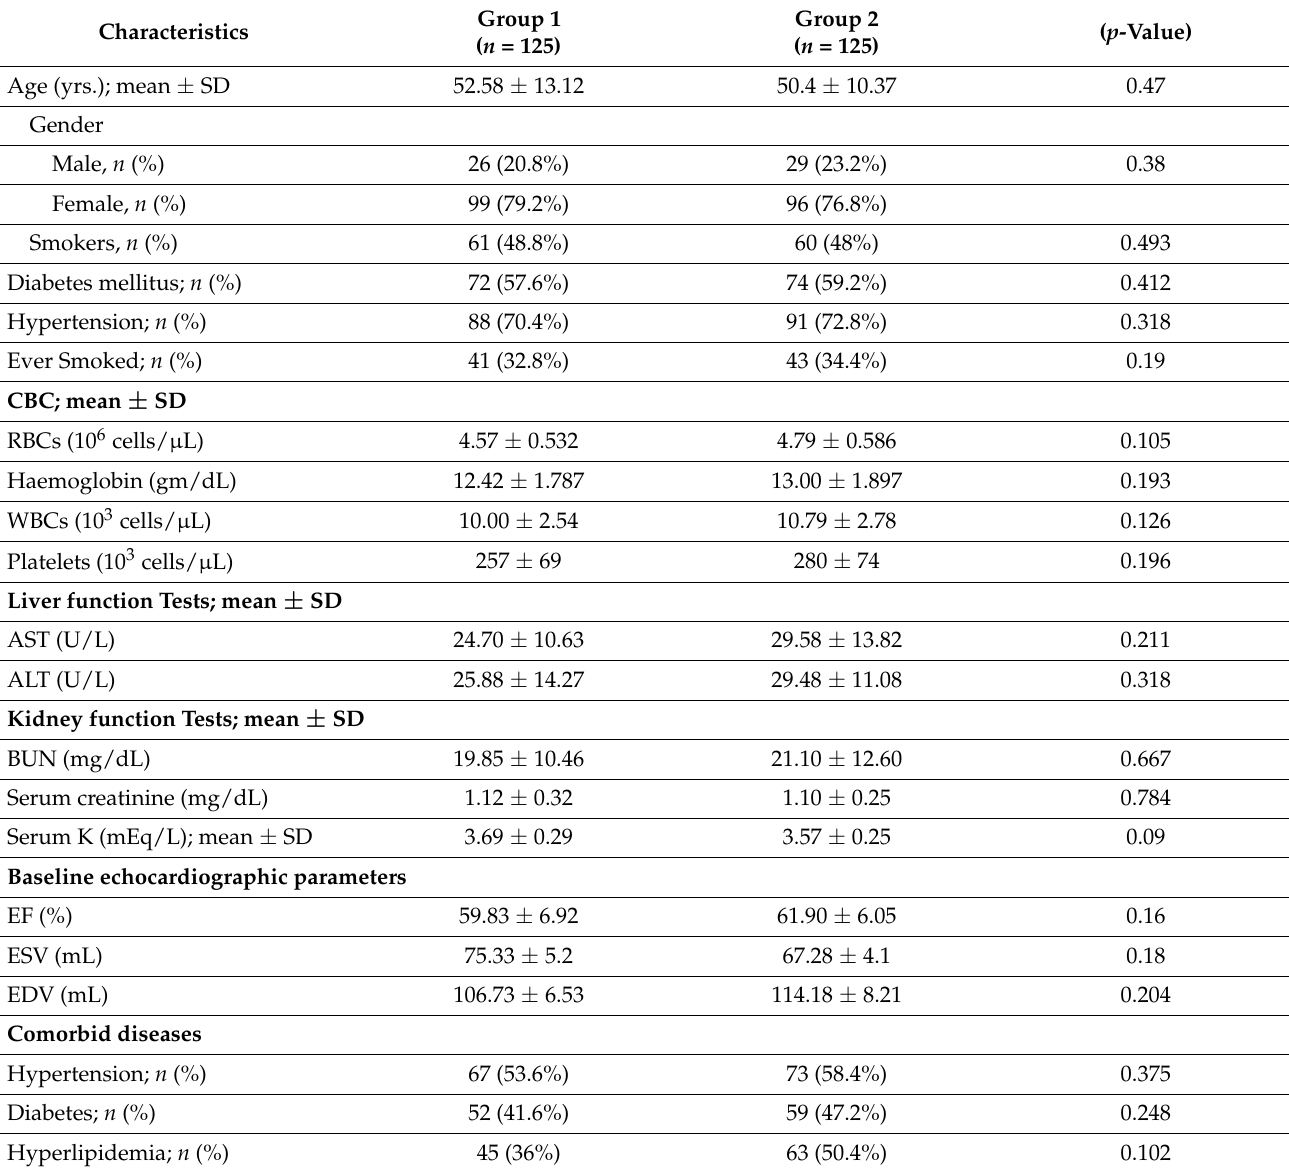
Table 1. Baseline Patients’ demographics and laboratory values in both